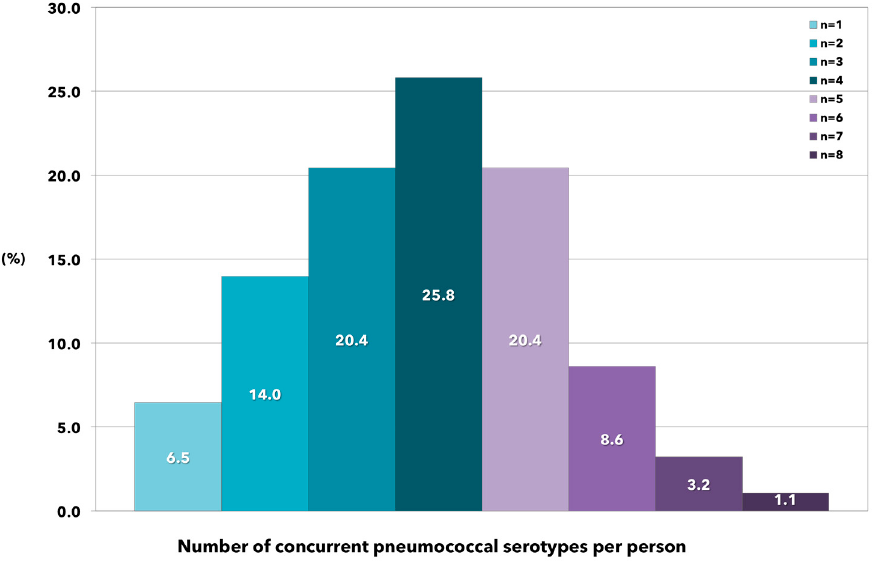
Figure 1. Relative proportions of concurrent PCV13 serotypes identified in oropharyngeal swab specimens collected from healthy subjects positive for Streptococcus pneumoniae (co-colonization).